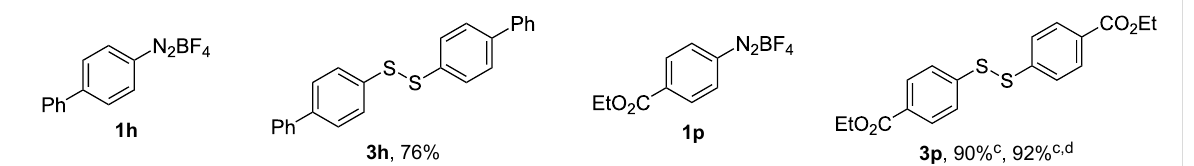
Table 4: Reaction scope of the visible light-mediated coupling of arenediazonium tetrafluoroborates 1 with CS 2 ( 2 ). (continued)